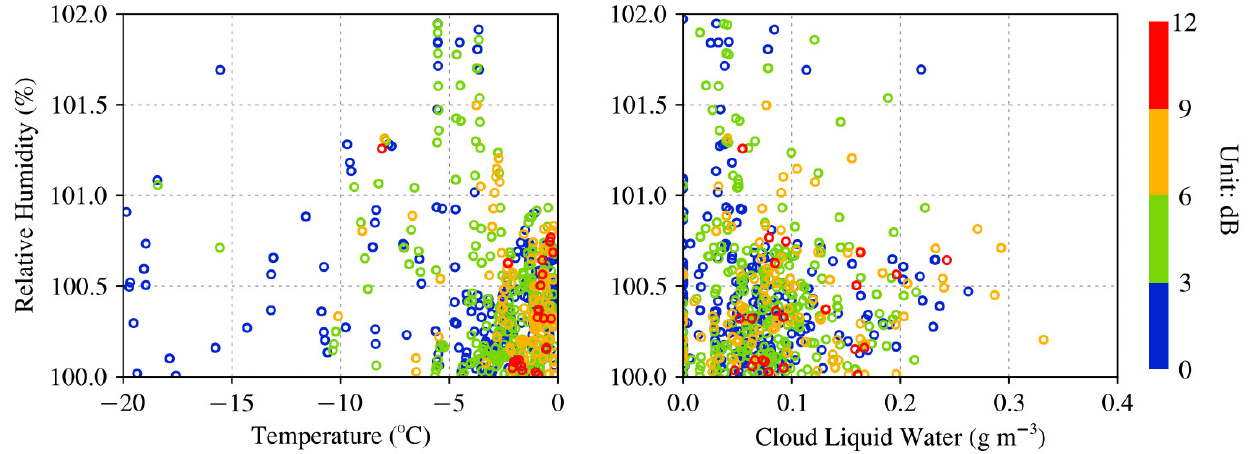
Figure 8. Scatterplots between relative humidity and temperature ( left panel) as well as relative humidity and cloud liquid water ( right panel) for supersaturation measurements. Colors correspond to DFR Ku/Ka values.